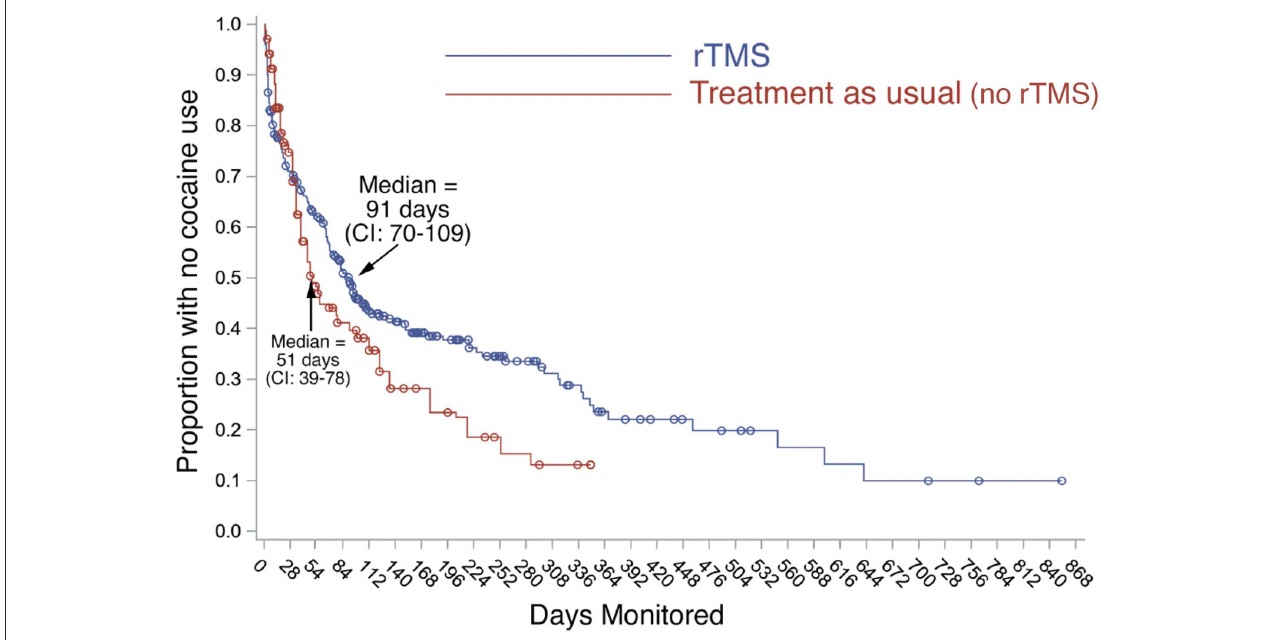
FIGURE 1 | Time to first resumption of cocaine use in full sample and comparison cohort. Blue line: Proportion of our patients ( n = 284) remaining abstinent from cocaine after the first course of rTMS, monitored by urine screening, self-report, and family corroboration. Day 0 is 8 days after the initial course of rTMS. rTMS continued during follow-up (not shown in this figure). Red line: Proportion of patients in a separate cohort of 173 “treatment as usual (no-rTMS)” outpatients in New Haven, CT ( 17). Like our rTMS patients, they achieved initial abstinence and were followed up during ongoing treatment (group and individual psychotherapy) for cocaine-use